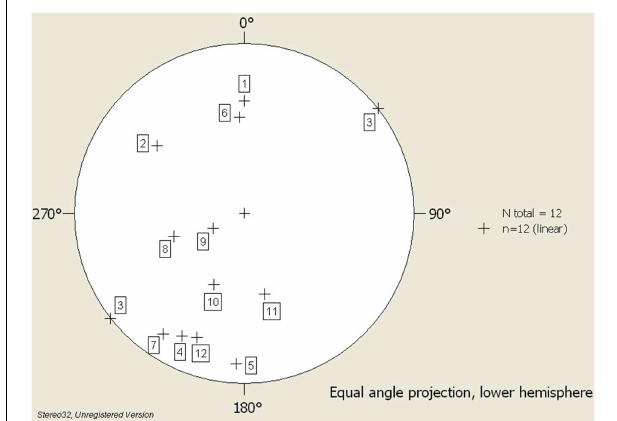
FIGURE 7 | Equal angle, lower hemisphere projection of the Kmax for each layer investigated: 1-10 from bottom to top of the paleo-tsunami deposit, 11 and 12 for the 2004 IOT tsunami